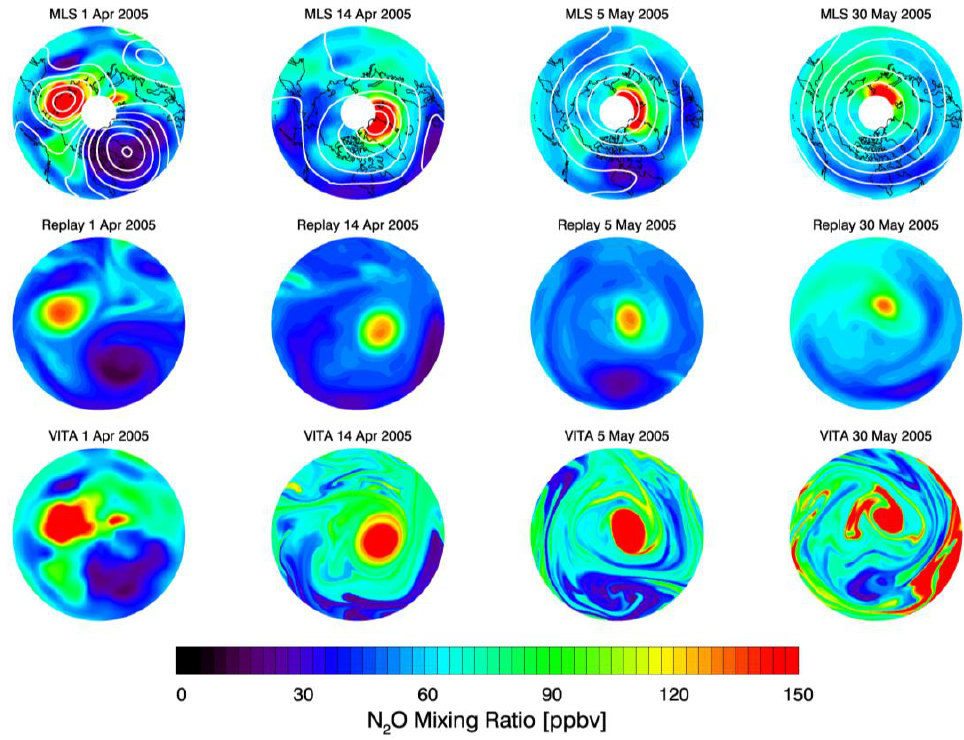
Fig. 9. MLS N 2 O mixing ratio at 850 K from 50–90 ◦ N for 1 and 14 April and for 5 and 30 May 2005 overlaid with contours of 10hPa Figure 9. MLS N geopotential height at 100-m intervals (first row). Red (blue) indicates high (low) N 2 O values. Replay N 2 O simulations for the same days (second row). VITA N 2 O simulations initialized on 1 April 2005 (third May 2005 overlaid with contours of 10 hPa geopotential height at 100-m intervals (first row). 3 Red (blue) indicates high (low) N (second row). VITA N